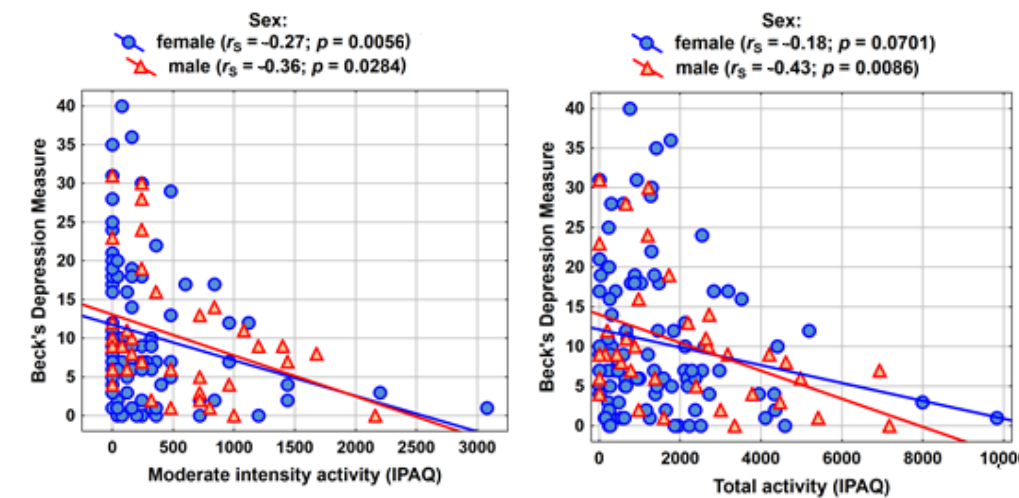
Figure 1. Correlations between moderate-intensity activity and total activity with the measure of depression. r S —Spearman correlation coefficient. p value—result of testing the significance of the Spearman correlation coefficient.